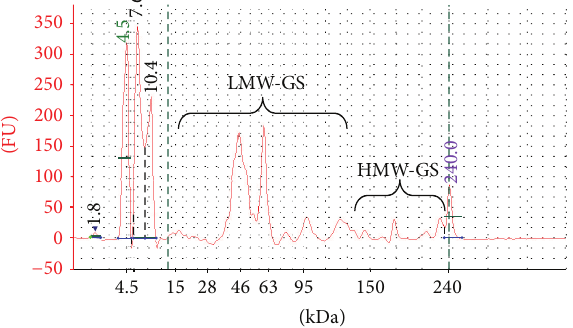
Figure 1: Electrophoregram of glutenins of cultivar